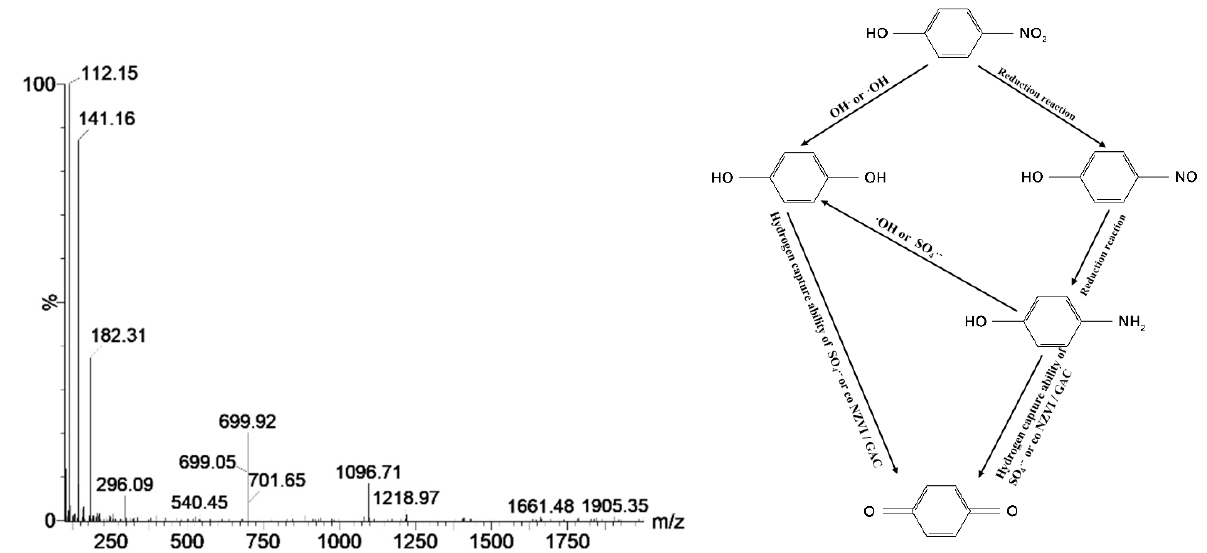
Figure 17. Analysis of degradation process of PNP by Co-nZVI/GAC.